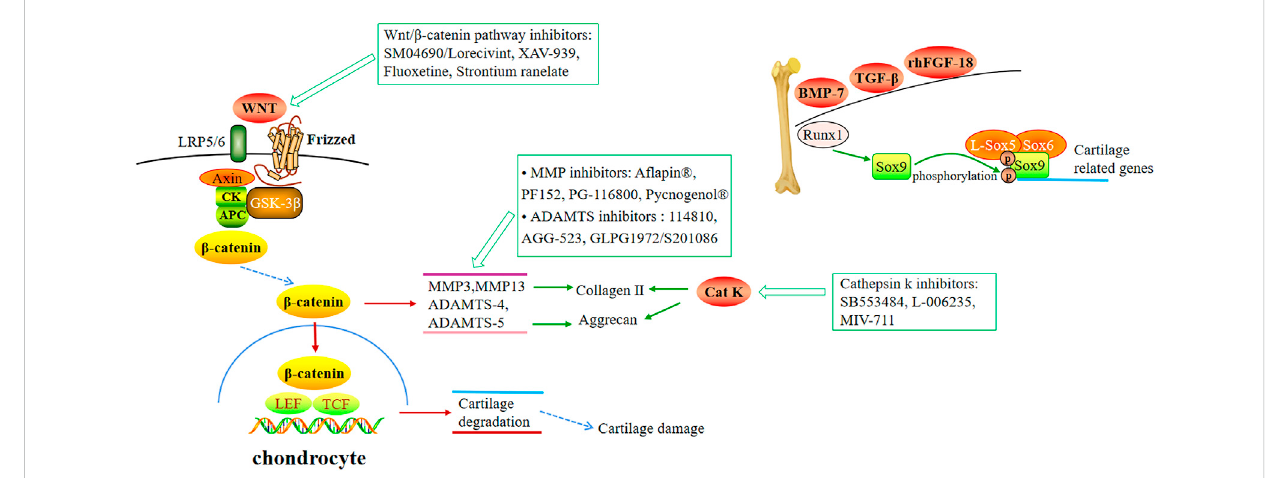
FIGURE 3 Small molecular therapeutic agents focused on targeting articular